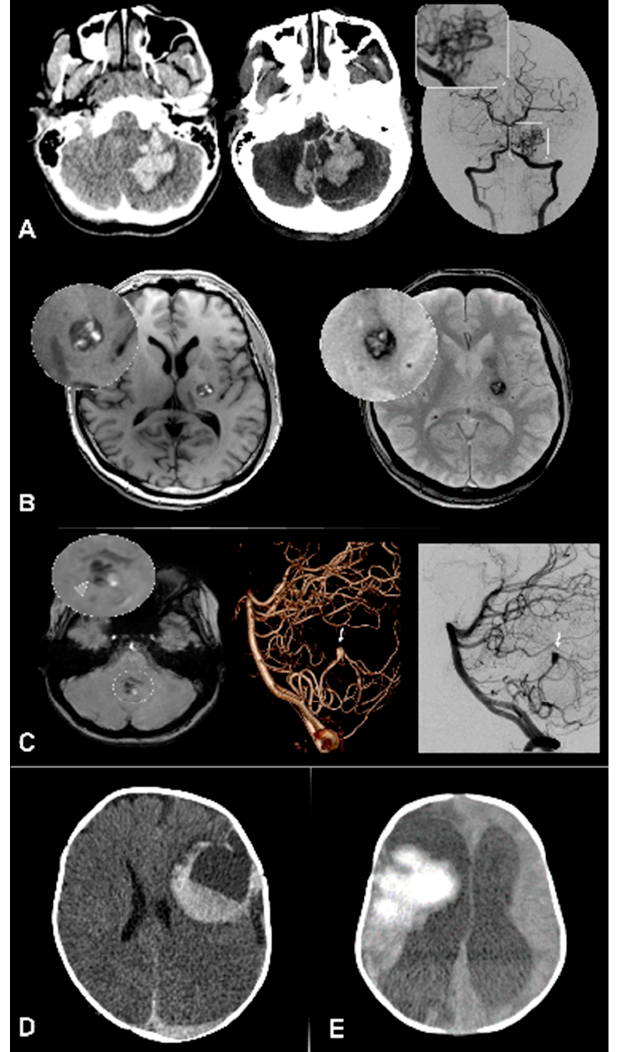
Figure 1. Pediatric intracerebral hemorrhage (ICH) main etiologies. ( A ) Left cerebellar mid peduncular hemorrhage, demonstrated on computed tomography (CT) and CT-angiography; digital subtraction angiography (DSA) (right and inset) shows malformative vessels with PICA and AICA feeders, a nidus and deep venous outflow corresponding to an arteriovenous malformation. ( B ) Left internal capsule cavernoma, with distinctive heterogeneous signal on T1 (left) and hyposignal on T2 * (right). ( C ) Smaller ICH in the cerebellar vermis (arrowhead). DSA shows a fusiform, likely dissecting, aneurysm. ( D ) Clotting factor deficiency revealed by a left supratentorial bleed. The presence of a fluid level is suggestive of a coagulation deficit. ( E ) Hemorrhagic transformation of a large right hemispheric ischemic stroke.